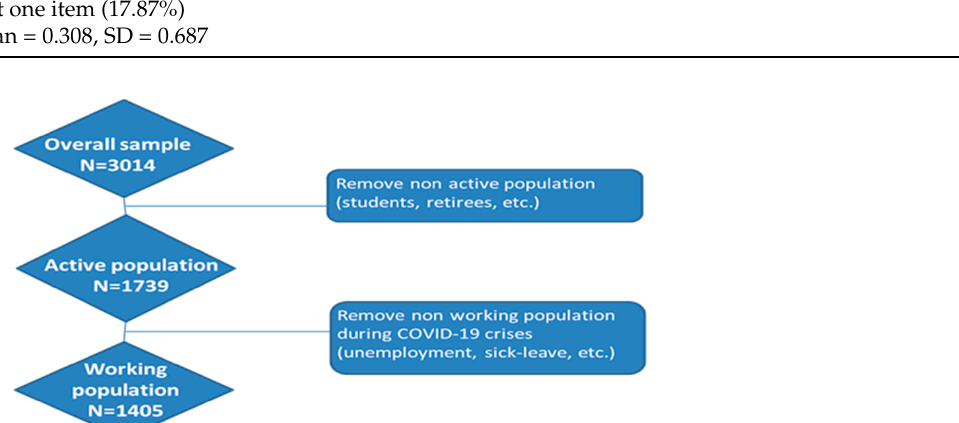
Figure 3. Process followed to select the answers to analyse from the survey “Tendencies in the digital society during COVID-19 pandemic in